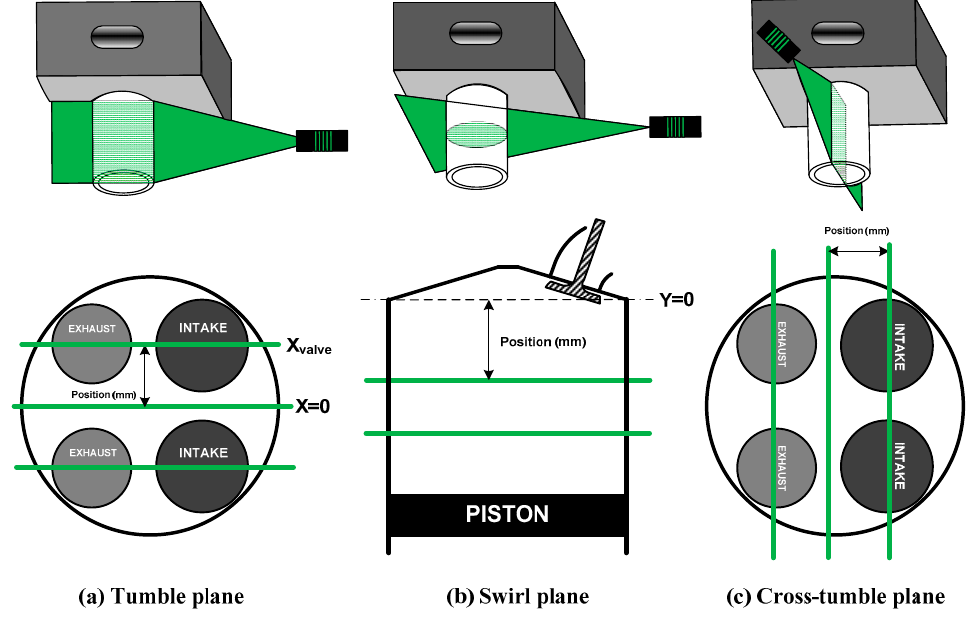
Figure 3. Particle Image Velocimetry (PIV) plane positions. ( a ) tumble planes; ( b ) swirl planes; ( c ) cross-tumble planes .